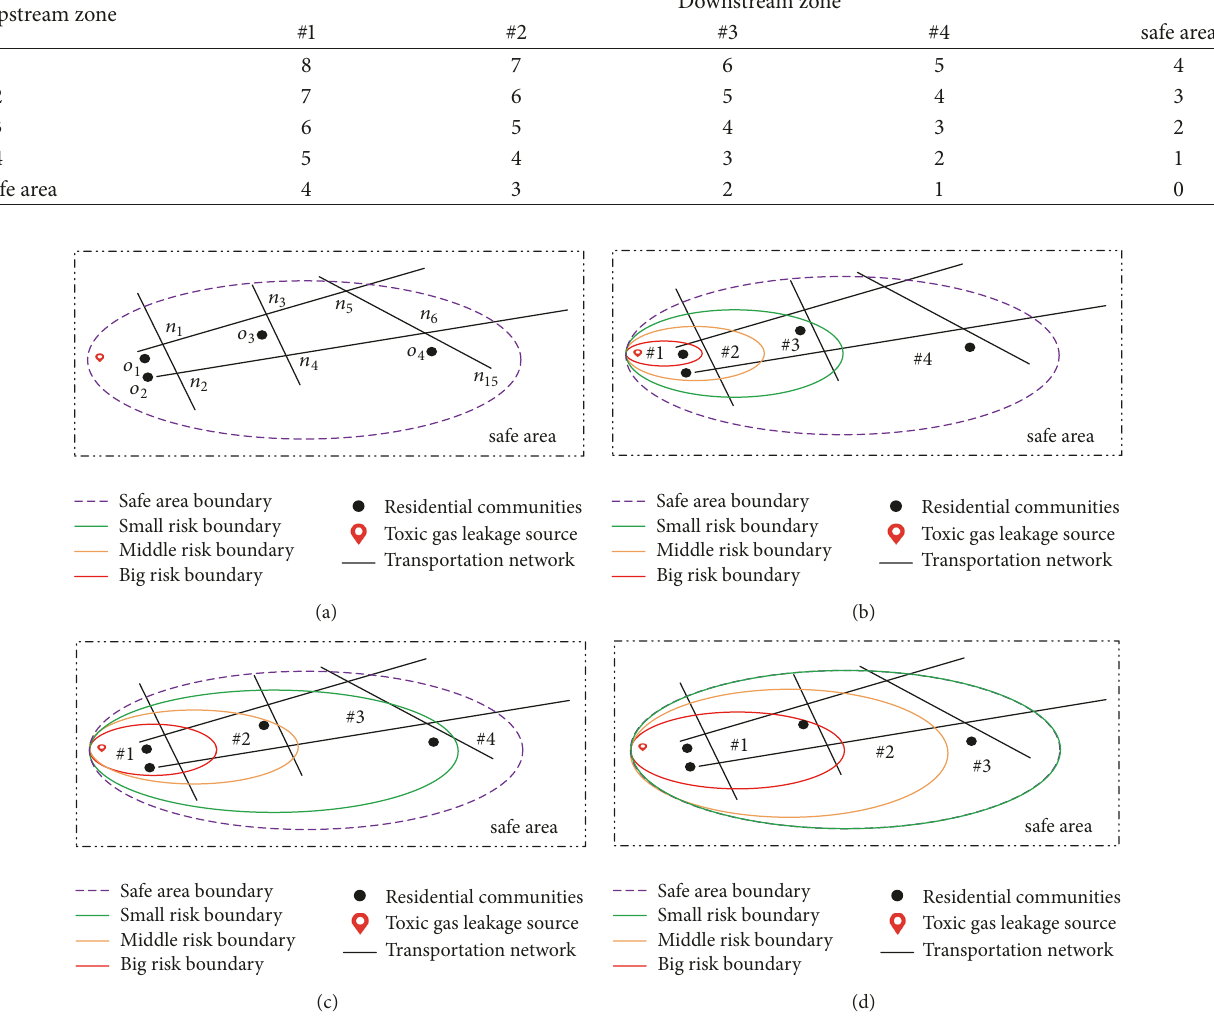
Figure 2: Division of risk zones under toxic gas dispersion at (a) t =0; (b) t = t 1 ; (c) t = t 2 ; (d) t = t 3